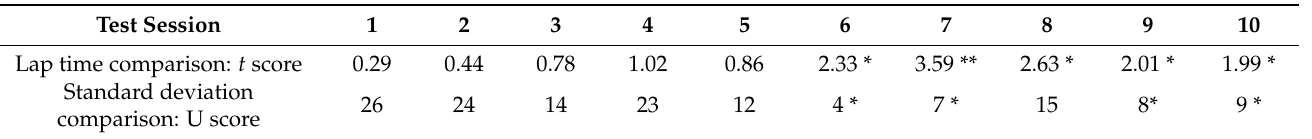
Table A2. Session-level comparison between the experimental and control groups. t score and U score results for the comparison of the means and standard deviations, respectively, of lap average velocities for the two